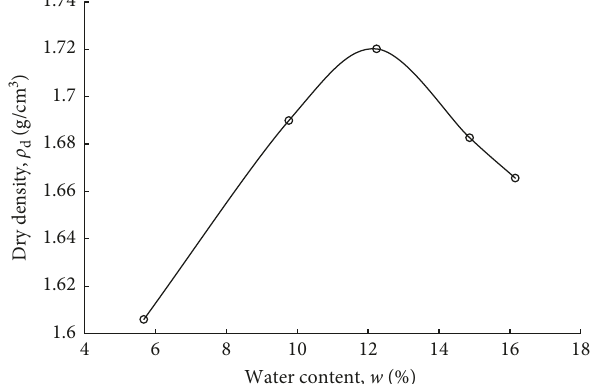
Figure 6: Dry density versus water content from compaction tests.